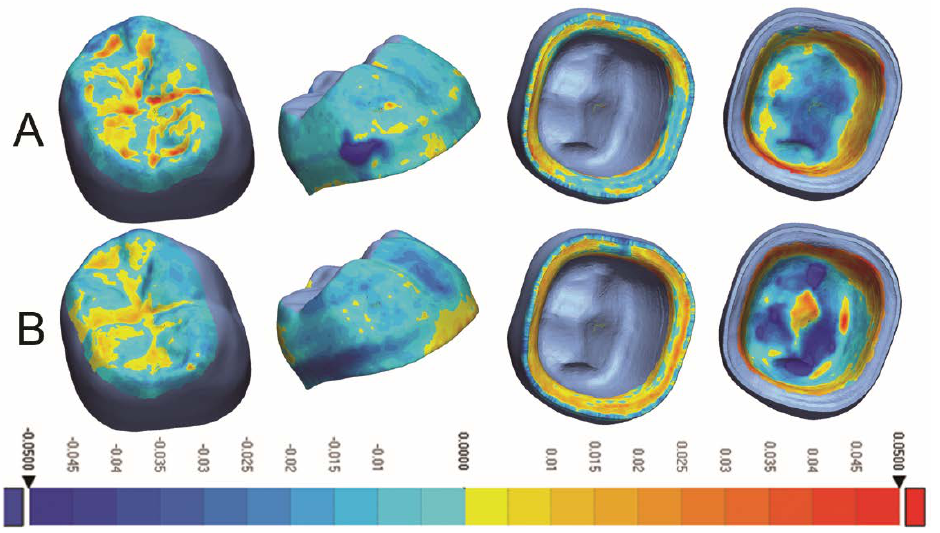
Figure 3. Colorimetric analysis of trueness for ( A ) Milled crowns and ( B ) 3D-Printed crowns.